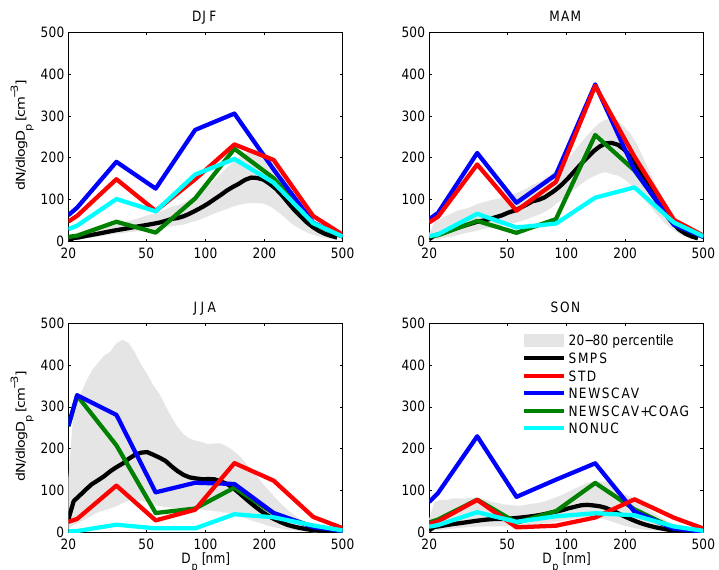
Figure 3. Seasonal-median number distributions from SMPS measurements at Alert (2011–2013) and for the GEOS-Chem-TOMAS dry size distribution simulations (described in Table 1). The measurement 20–80th percentile is in grey shading. Simulations are shown in colour as indicated by